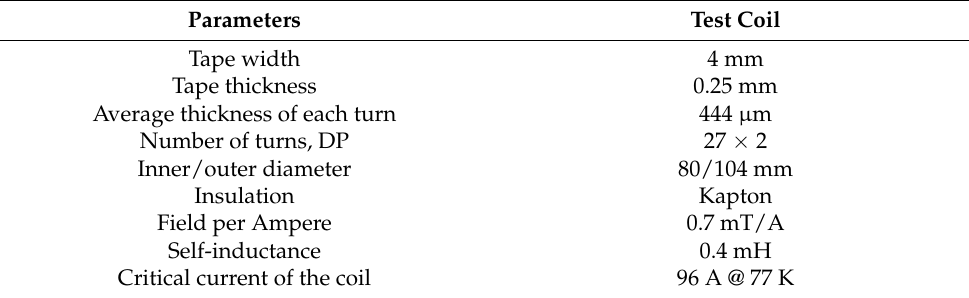
Figure 1. Experiment platform for discharging tests of the HTS coil. Table 1. Specifications of test